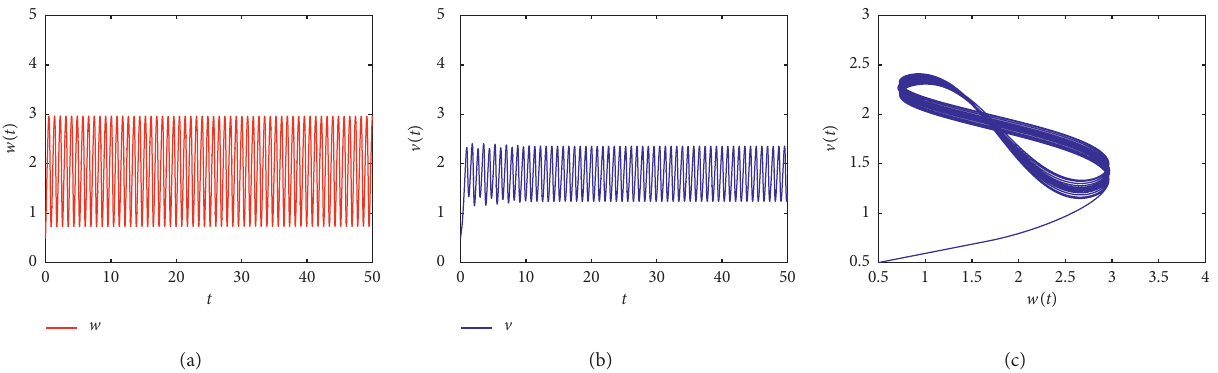
Figure 3: Computer simulation of the paths w ( t ) and v ( t ) for system (16) with the initial value ( w ( 0 ) , v ( 0 )) � ( 0 . 5 , 0 . 5 ) and η ( t ) �